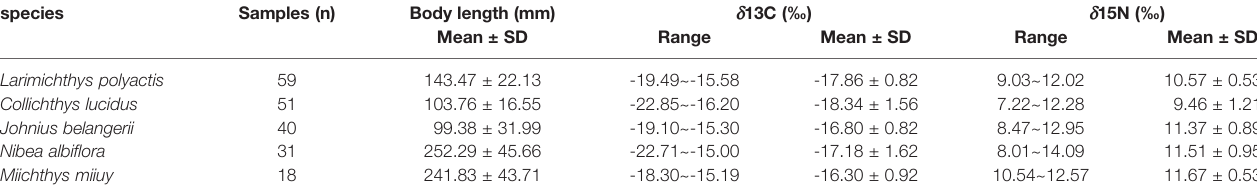
TABLE 1 | d 13 C and d 15 N values observed for fi ve sciaenid fi sh species in Zhoushan Archipelago waters collected between 2019 and 2021. species Samples